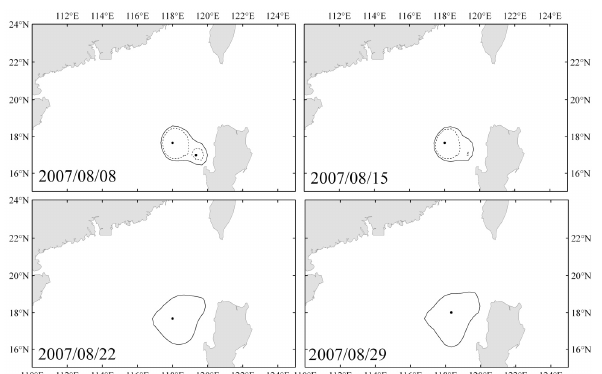
Fig. 9. Evolution snapshots of ACE3’s merging event. The compos- Figure 9. Evolution snapshots of ACE3’s merging event. The composite border is delineated 2 ite border is delineated by the solid line, while the footprint border by the solid line while the footprint border is delineated by the dashed line. 3 is delineated by the dashed line.